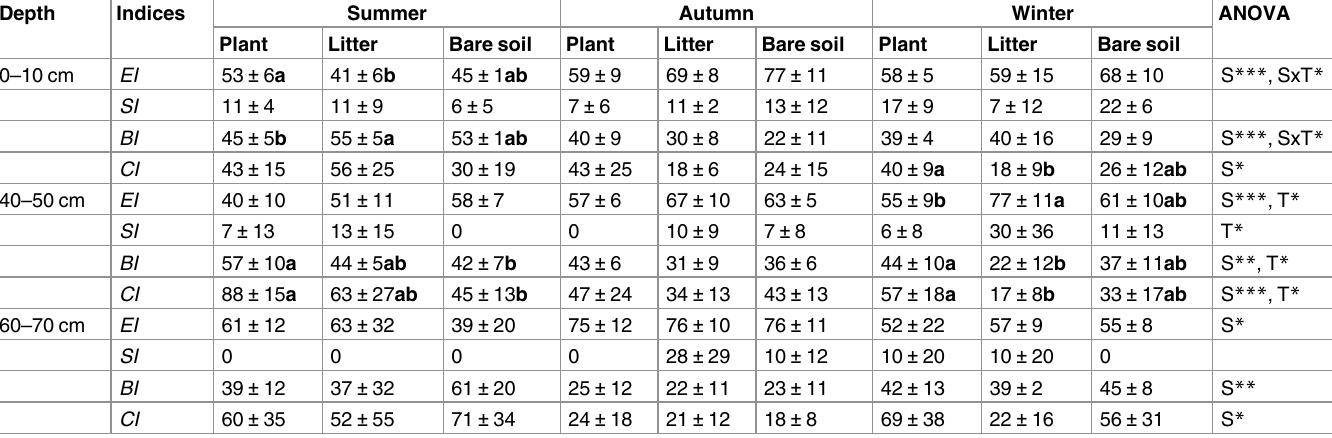
Table 1. Nematode food web conditions (Community Indices ± SD) at plots cropped with maize (plant), amended with maize shoot litter (litter) or bare soil, in topsoil (0–10 cm), rooted zone (40–50cm) and root free zone (60–70cm) after two vegetation periods.